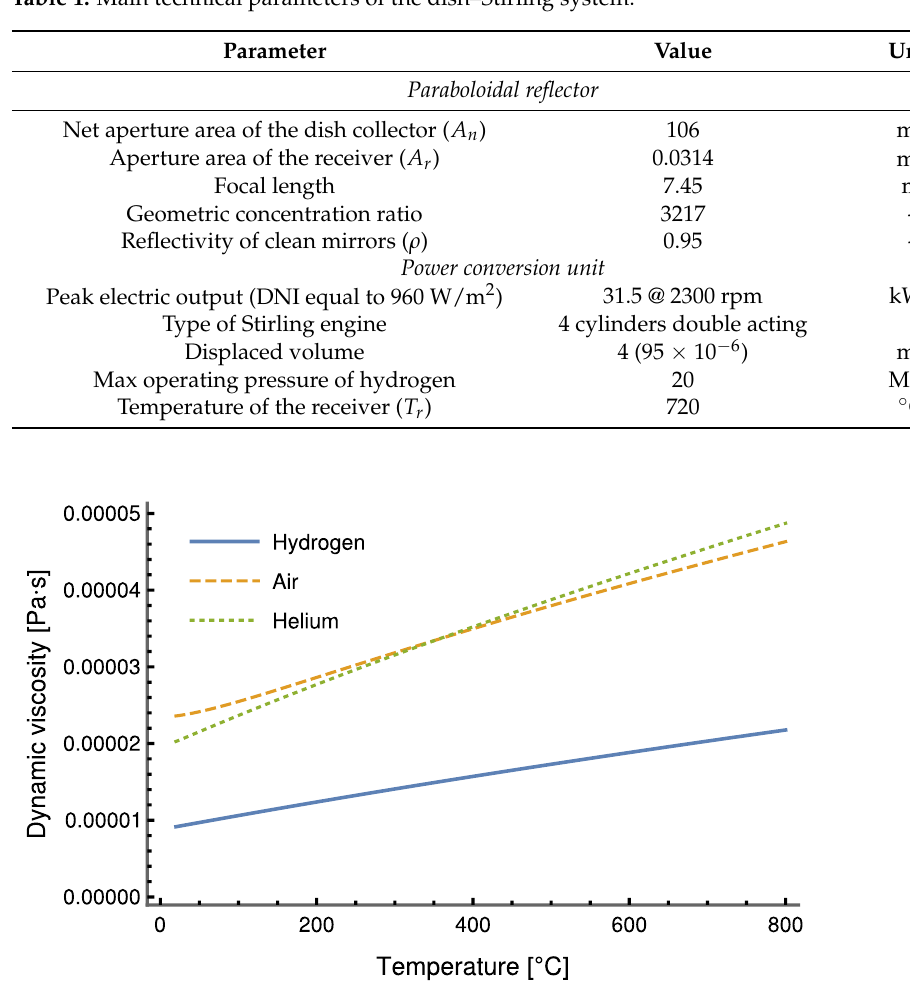
Figure 2. Dynamic viscosity for hydrogen, helium, and air versus temperature with a pressure value of 20 MPa.